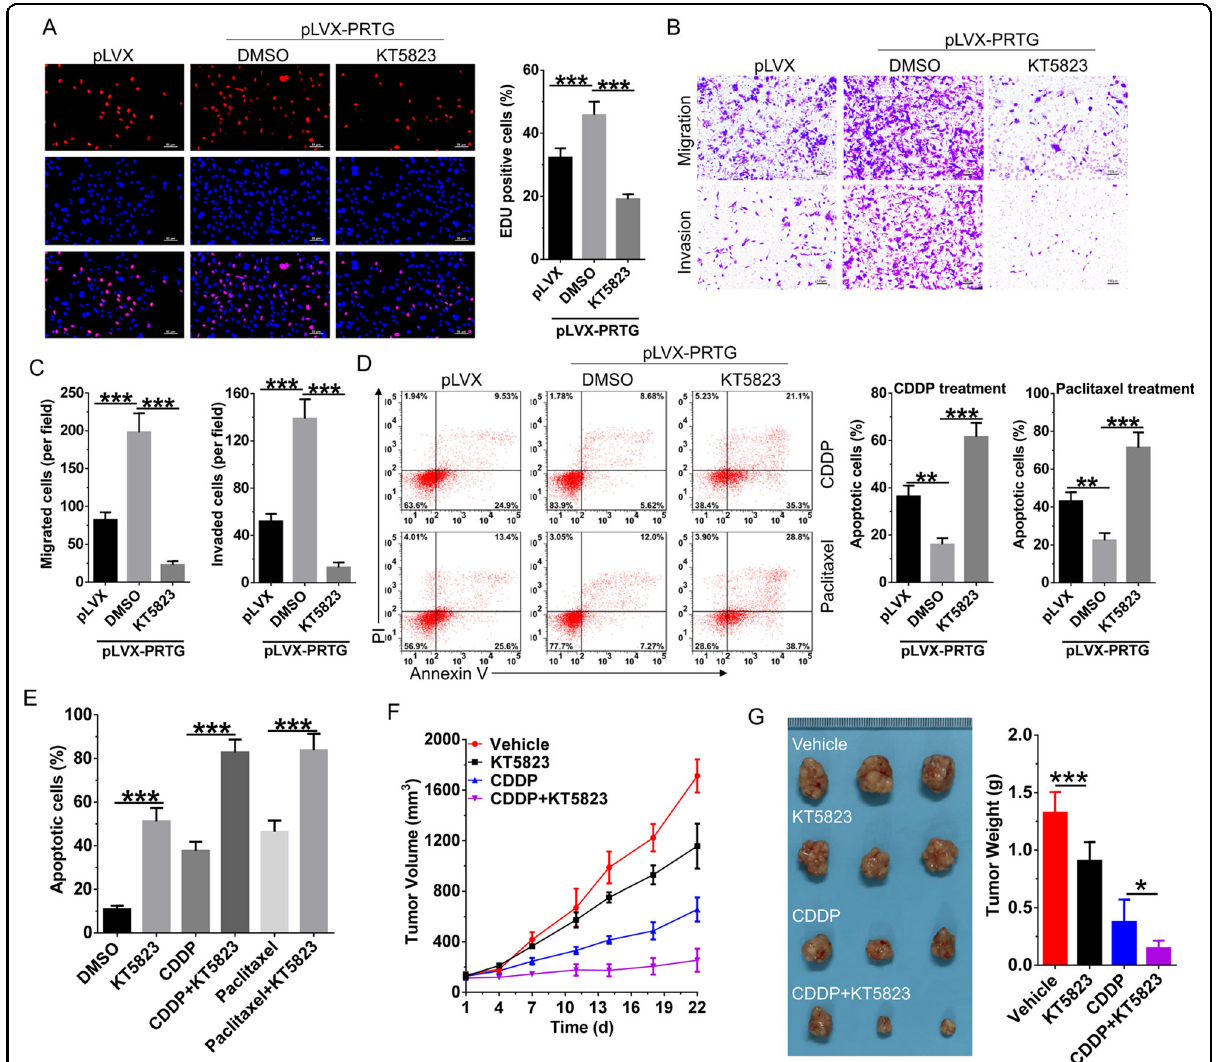
Fig. 6 PKG inhibitor antagonizes the effect of PRTG-induced GC progression and enhances the effect of chemotherapy. A The EdU was used to determine the proliferation of PRTG-overexpressing AGS cells after treated with PKG inhibitor (KT5823, 1 μ M) for 24 h. B Migration and invasion of PRTG-overexpressing AGS cells was determined after treated with PKG inhibitor (KT5823, 1 μ M) for 24 h. C Statistical analysis of migrated and invaded AGS cells ( n = 3). D Apoptosis was detected in PRTG-overexpressing AGS cells after simultaneously treated with PKG inhibitor (KT5823, 1 μ M) and chemotherapy drugs (paclitaxel, 20 nM; or CDDP, 5 μ M) for 48 h. E Flow cytometry was used to examine the synergetic effect of PKG inhibitor (KT5823) and chemotherapy drugs on apoptosis of AGS cells in vitro. F In vivo tumor-bearing mouse model ( n = 12) was used to detect the synergistic effect of PKG inhibitor (KT5823) and CDDP on the growth of AGS cells. G Mice were sacri fi ced, and xenografts tumors were harvested and weighed 22 days after drug treatment, xenografts tumors of 3 mice were presented. Data were presented as mean ± SD from the three independent replicates. * P < 0.05; ** P < 0.01; *** P < 0.0001. CDDP,